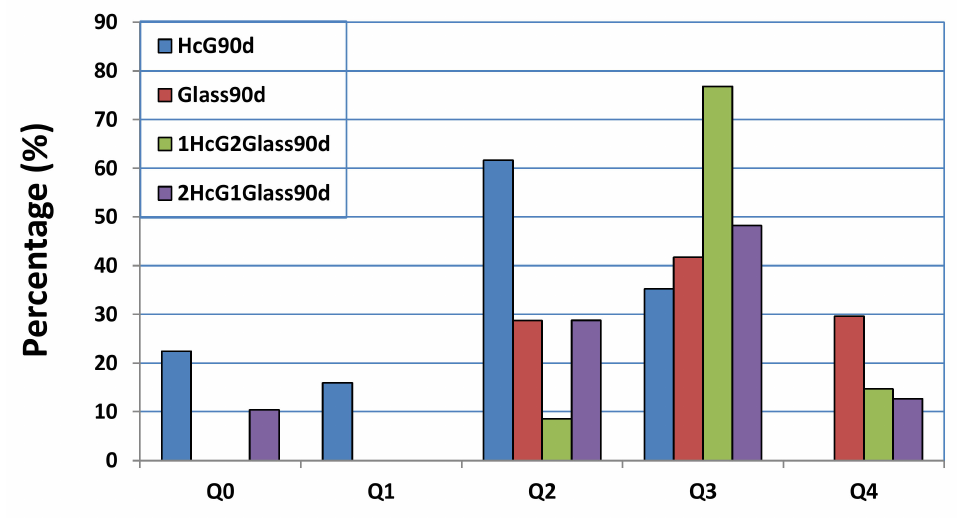
Figure 13. Deconvolution of the 29 Si NMR signal from the HcG/glass mixtures at 90 days of hydration, compared with HcG and glass at the same age.